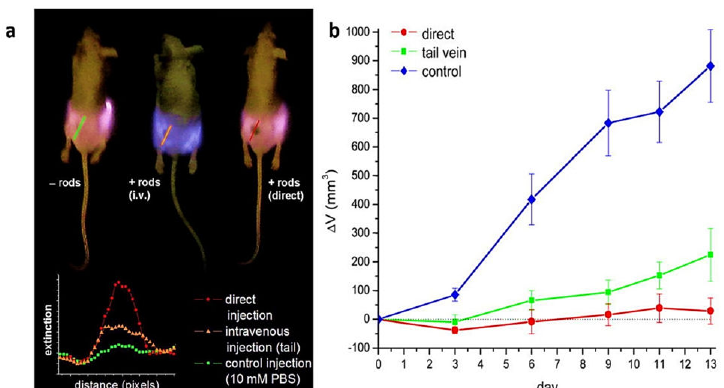
Figure 11. ( a ) NIR transmission images of mice before PPTT treatments. Inset shows intensity line-scans of NIR extinction at tumor sites for control ( ), intravenous ( ), and direct ( ) administration of pegylated gold nanorods. Control mice were interstitially injected with 15 µ L 10 mM PBS alone. In contrast, directly administered mice received interstitial injections of 15 µ L pegylated gold nanorods (OD λ = 800 = 40, 2 min accumulation), and intravenously administered mice received 100 µ L pegylated gold nanorod (OD λ = 800 = 120, 24 h accumulation) injections. ( b ) Average change in tumor volume for HSC-3 xenografts following near-infrared PPTT treatment by control ( ), intravenous ( ), and direct ( ) injection of pegylated gold nanorods. Errors for control (n = 10), direct injection (n = 8), and intravenous injection (n = 7) groups were reported as the standard error of the means. Control mice were treated by interstitial injection of 15 µ L 10 mM PBS alone. At the same time, intravenous PPTT treatments were performed by administering 100 µ L pegylated gold nanorods (OD λ = 800 = 120, 24 h accumulation) followed by 10 min of 1.7–1.9 W/cm 2 NIR laser exposure. Direct PPTT treatments were performed by administering 15 µ L pegylated gold nanorods (OD λ = 800 = 40, 2 min accumulation) followed by 10 min of 0.9–1.1 W/cm 2 NIR laser exposure [71,77]. Reprinted with permission from ref. [71,77]. Copyright 2008 Journal of the American Chemical